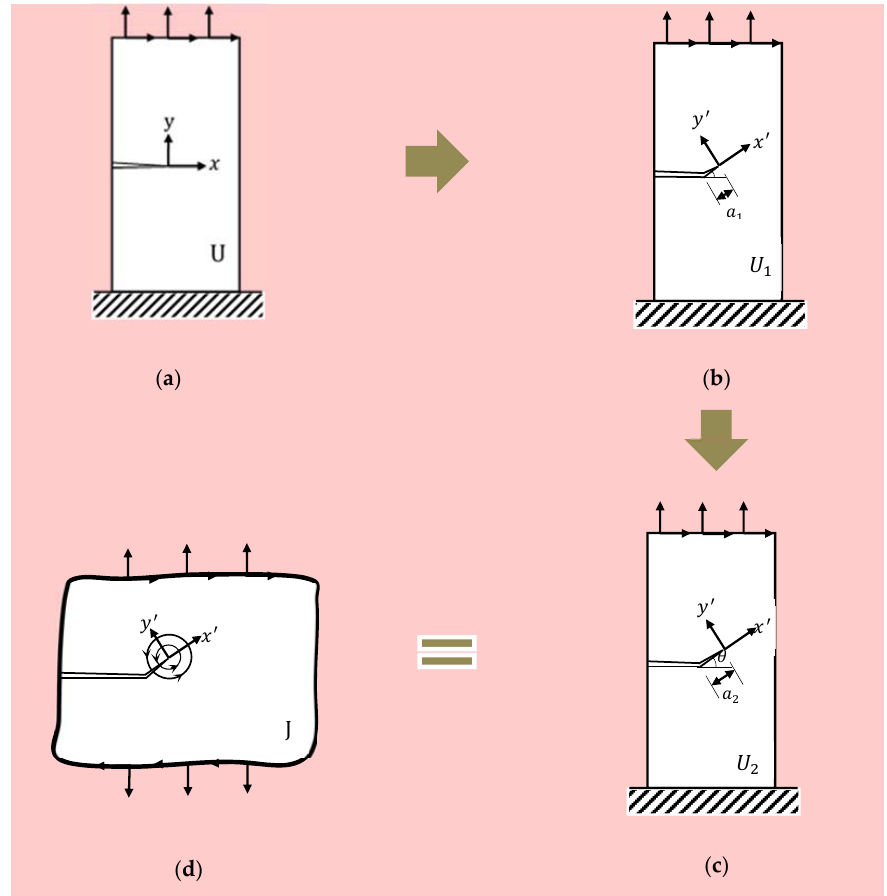
Figure 3. Cracked plane with kink extension. ( a ) Initial crack; ( b ) Kink crack a 1 ; ( c ) Kink crack a 2 ; ( d ) J integral.